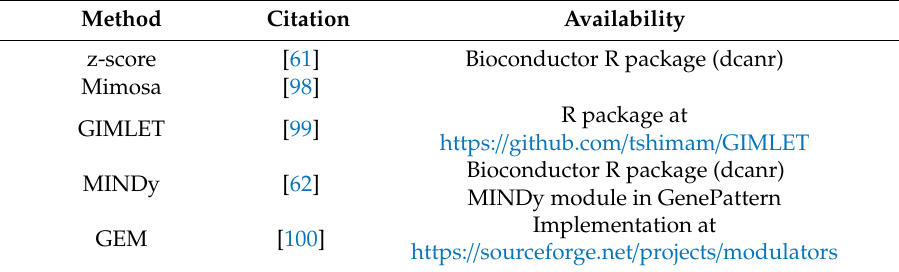
Table 6. Methods to infer modulators of gene